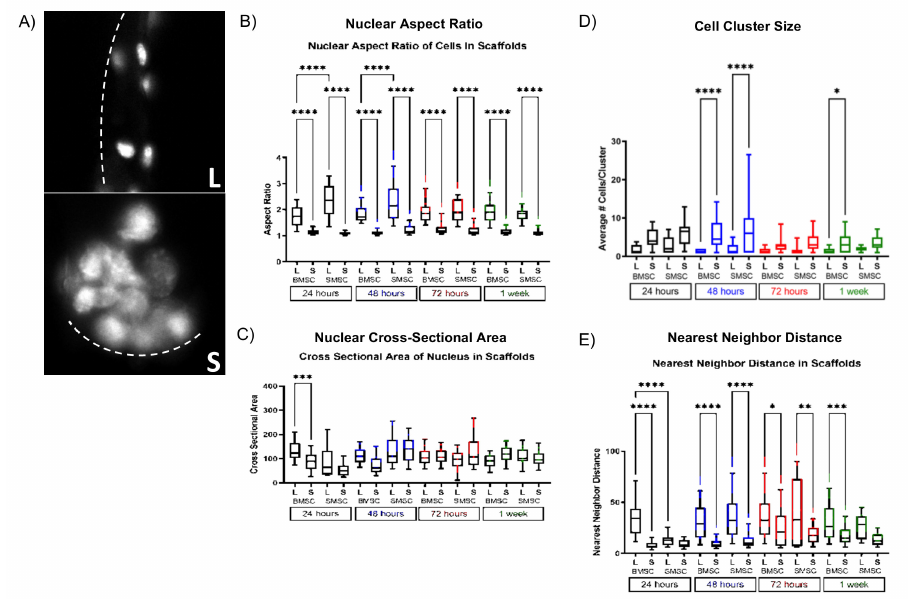
Figure 3. Confocal laser microscopy images of cell nuclei, seeded to large ( left ) and small ( right ) pore scaffolds, cultured for up to 7 days in vitro. Nuclei were measured for their aspect ratio over time (( A , B ); dotted line indicates scaffold macropore wall) and area ( C ) nearest neighbor distance ( D ), and number of cells per cluster ( E ). * = p < 0.05, ** = p < 0.01, *** = p < 0.001, **** = p <